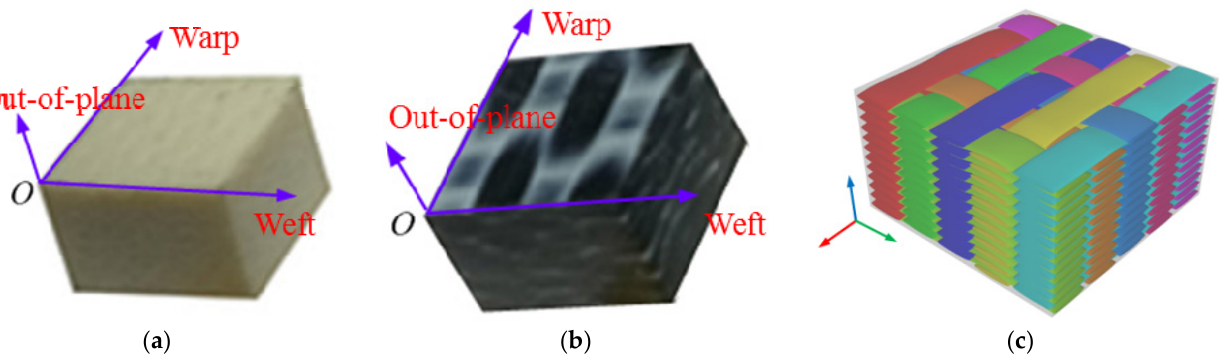
Figure 1. Thermoplastic composite specimens and weave construction. ( a ) Glass-fiber (GF)/ polyphenylene sulfide (PPS) specimen; ( b ) carbon-fiber (CF)/PPS specimen; ( c ) weave construction.